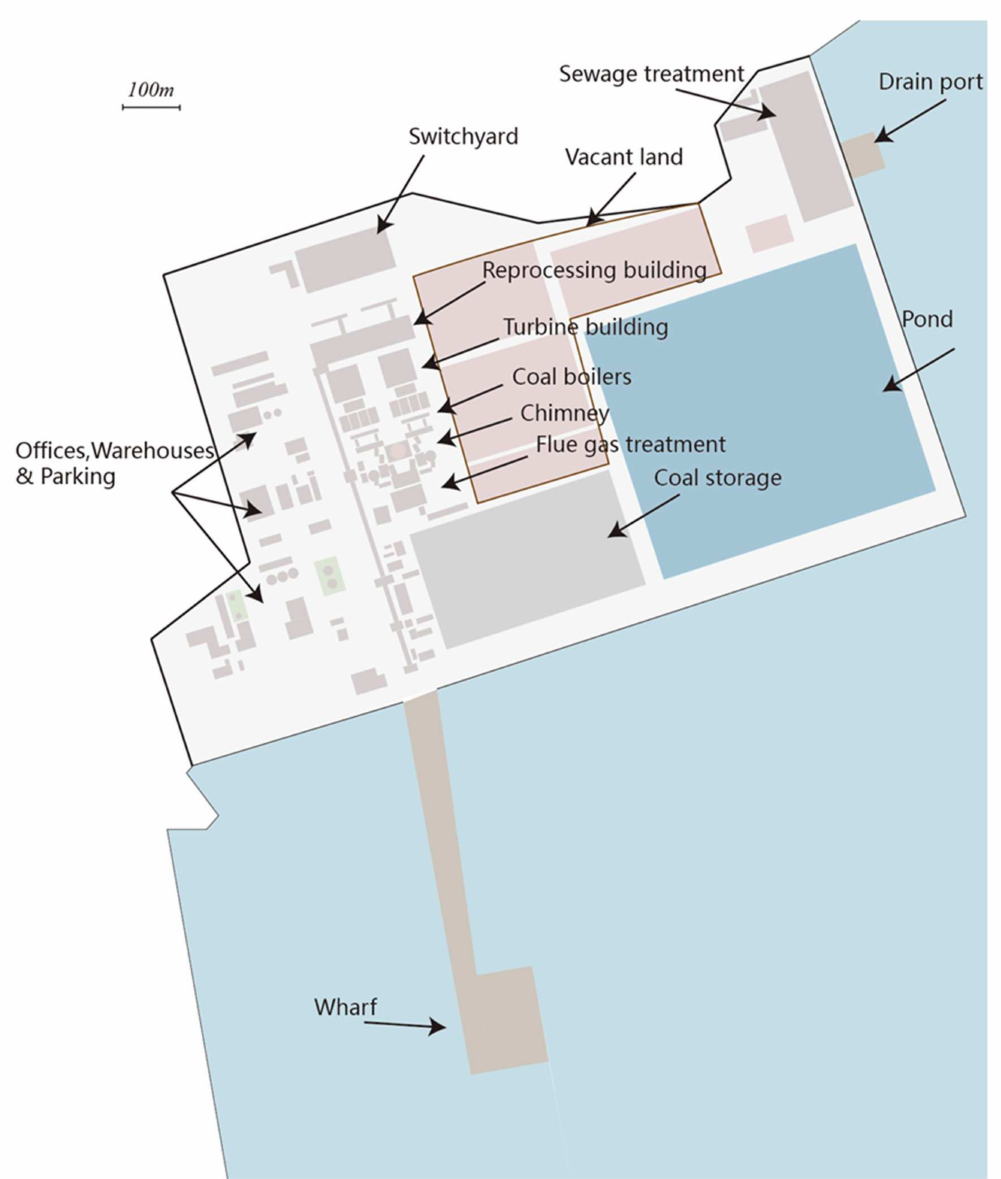
Figure 11. DALIAN Zhuanghe power plant site